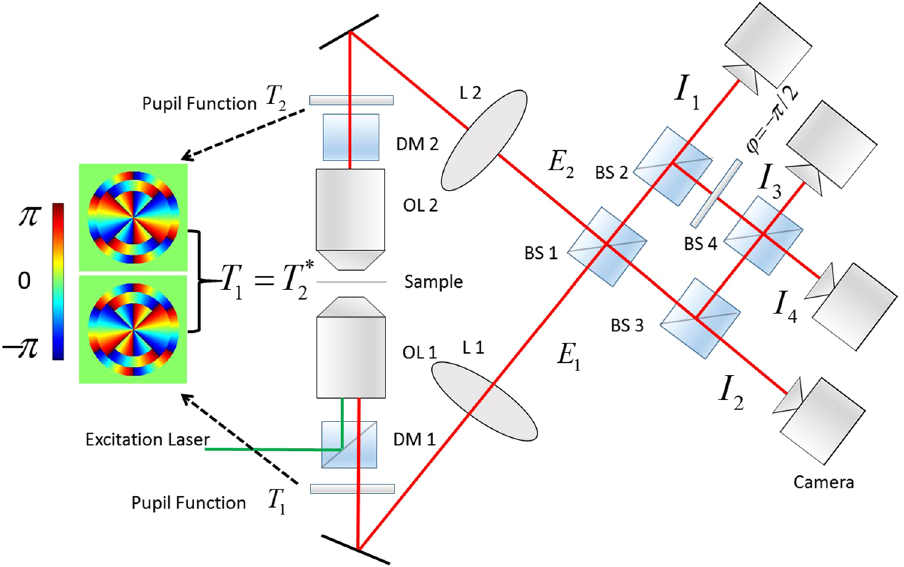
Figure 1. Schematic illustration of the setup for generating interferometric rotating PSF. In the interferometric detection scheme, the light fields E 1 , E 2 collected by objective lenses OL1 and OL2 are modulated by conjugate pupil functions T 1 and T 2 ( = ⁎ T T ) respectively. The beam splitters (BS) and an constant phase retardation plate 1 2 before BS 4 combines the light fields to produce four phase-shifted interferometric signals I 1 , I 2 , I 3 , I 4 on the cameras. DM: Dichroic mirror, BS: beam splitter. Inset: pupil functions (DH-P3) for generating the DH PSF. In the non-interferometric detection scheme, only one objective lens OL 1 is used, and the four beam splitters are removed from the detection